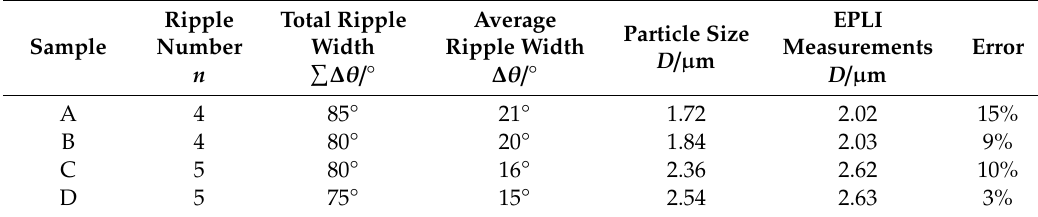
Table 3. Calculation parameters of particle size using the ripple width